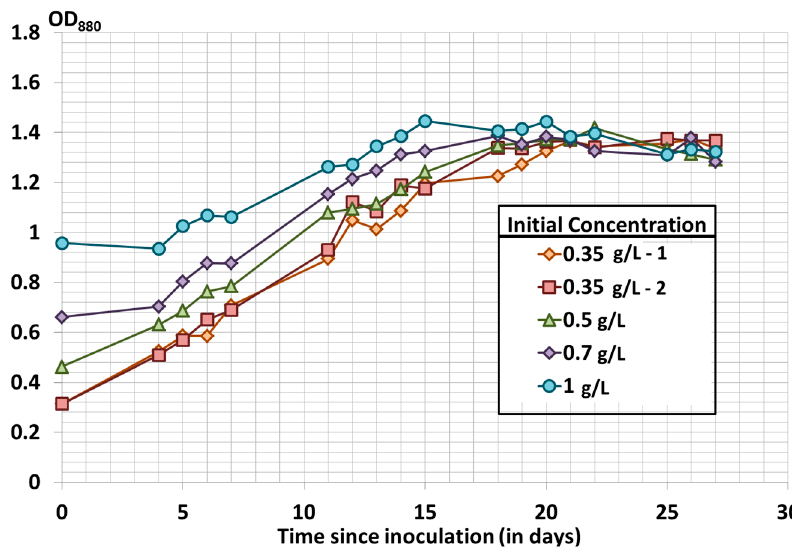
Figure 2. OD 880 measurements of Spirulina for four different initial dry weights in modified ZM: 0.35 g/L (orange diamonds and red squares, duplicate), 0.5 g/L (green triangles), 0.7 g/L (purple diamonds), and 1 g/L (blue circles). No replicates.